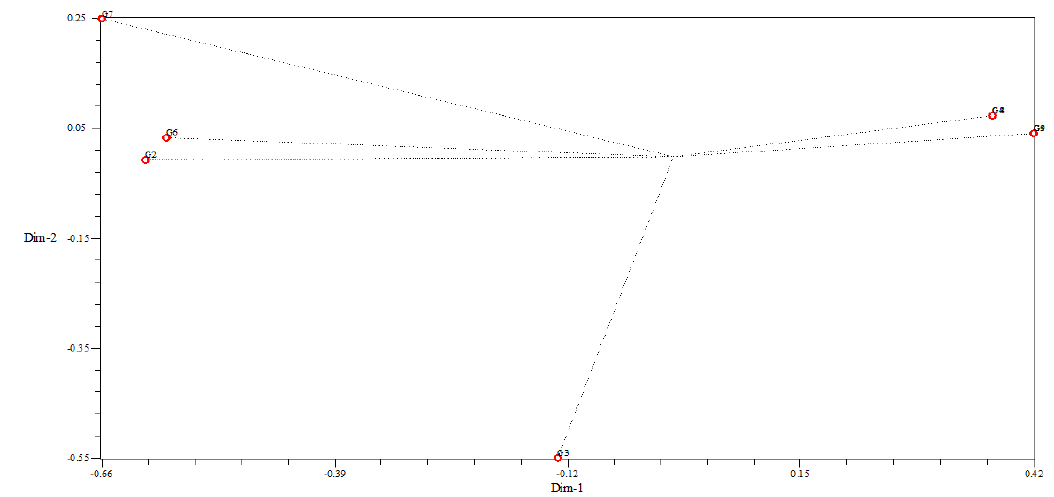
Fig. 3. The principal coordinate plot of Jacquard's genetic similarity for the first two principal